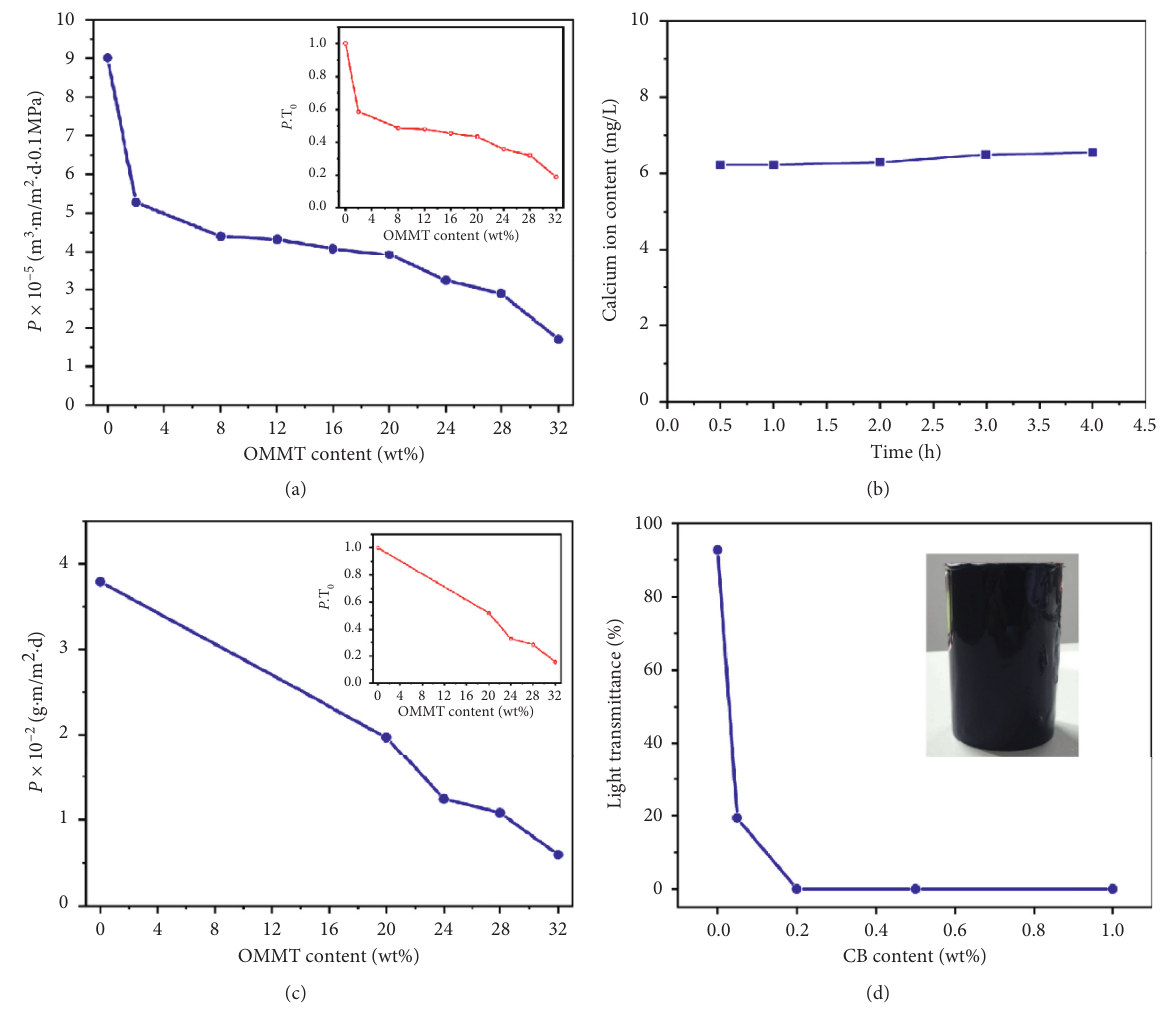
Figure 9: Molecule barrier property of the sealing film: (a) O light transmittance.